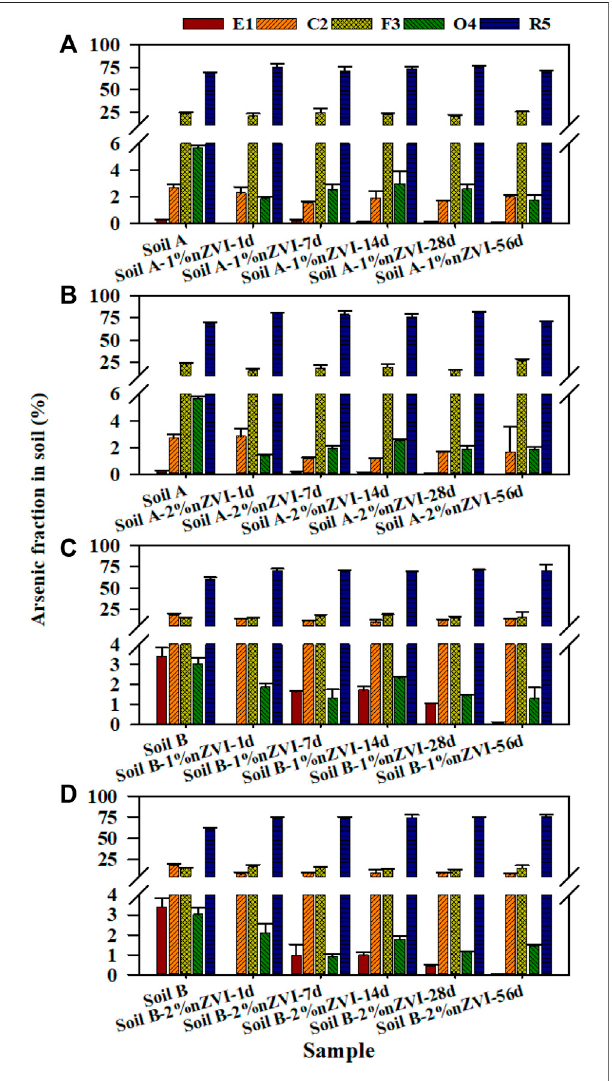
FIGURE2| Arsenicdistributionamong5fractionsfor (A) SoilA-1%nZVI treatment, (B) Soil A-2% nZVI treatment, (C) Soil B-1% treatment and (D) Soil B-2% nZVI treatment following the Tessier method. Error bars represent the standard deviation of duplicate analyses.